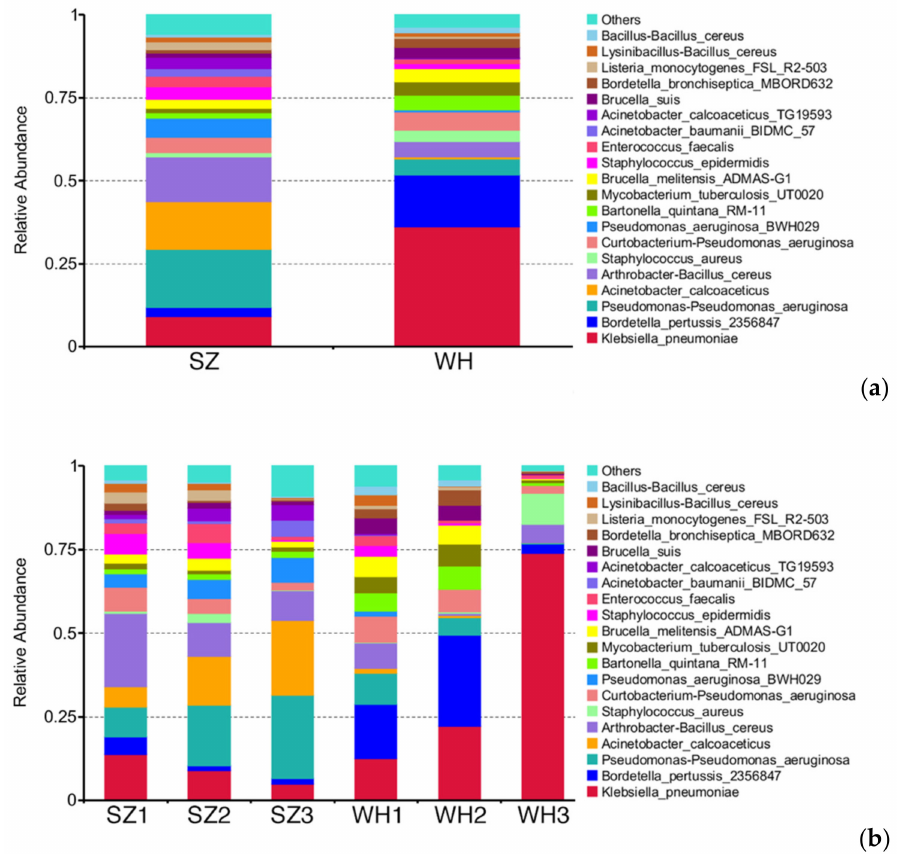
Figure 7. Relative abundances of human pathogenic bacteria (HPB) at the species level: ( a ) Top 20 rel- ative abundances of HPB in both landfills at the species level; ( b ) top 20 relative abundances of HPB in each sample at the species